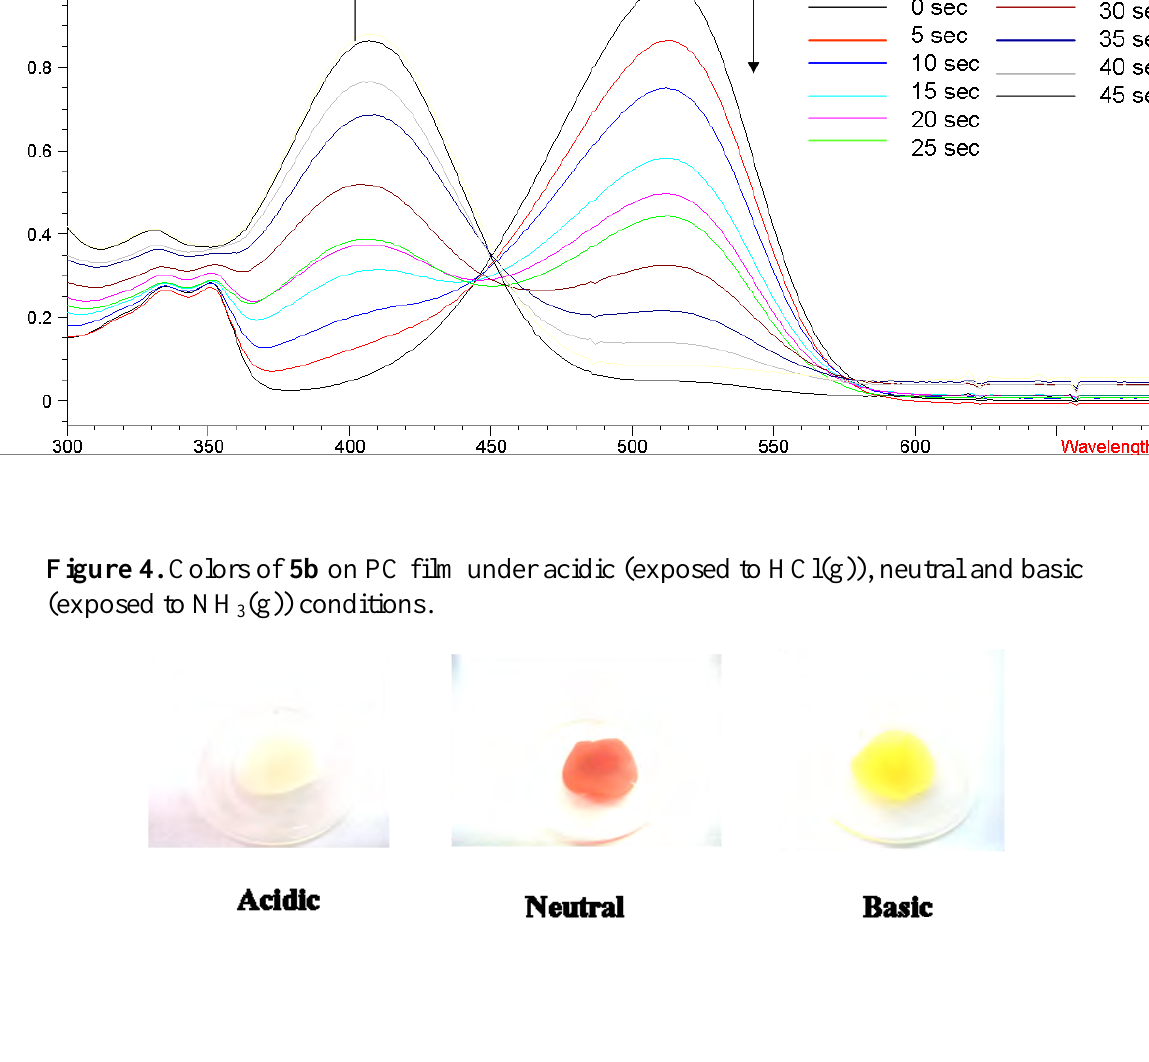
Figure 3. UV-vis curves of titration of 5b (2.01 x 10 -5 M in CH concentrations of NH